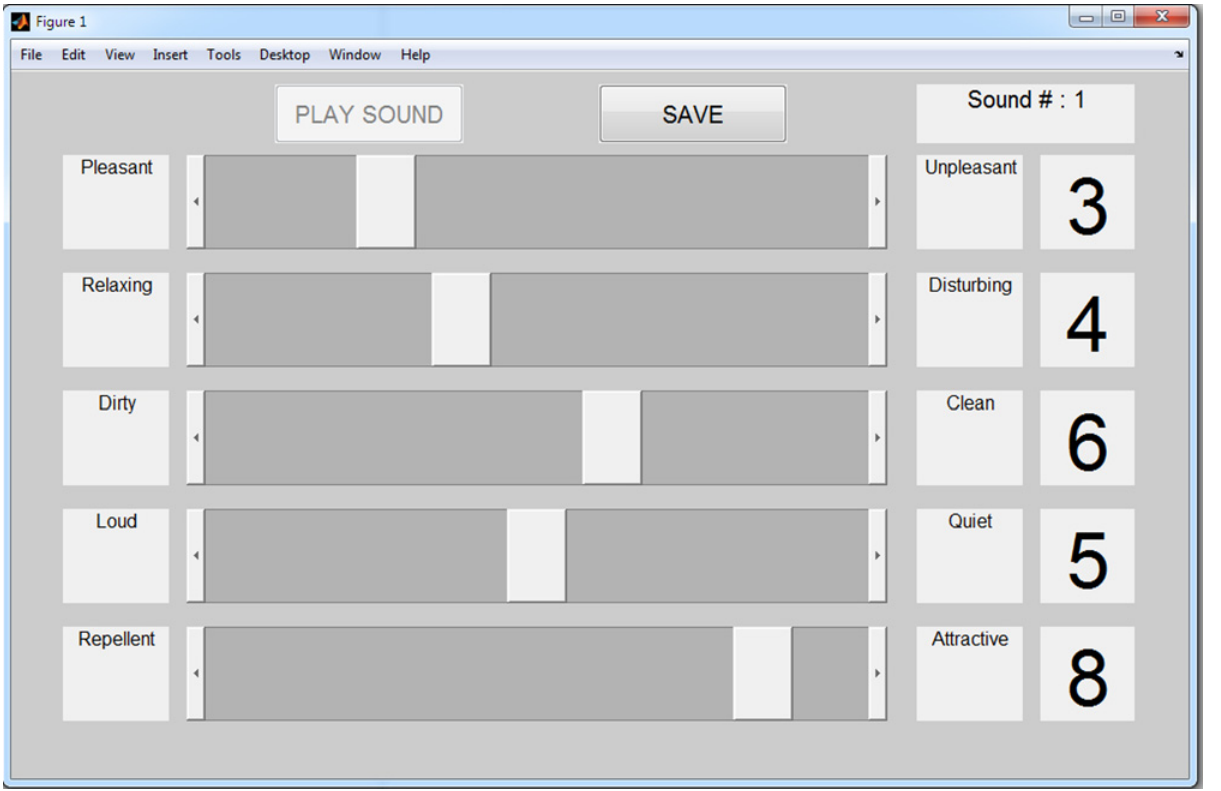
Fig 1. A representative screenshot of the test software in